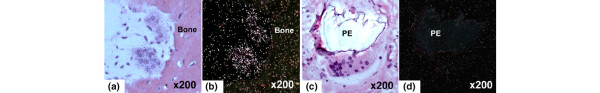
Detection of CTR mRNA in sections of human peri-implant tissues. The techniques used were in situ hybridization with a 35S-labeled antisense RNA probe ((a, c) bright field and (b, d) dark field). Expression of CTR mRNA is evident only in multinuclear cells in contact with the bone surface (panels a and b). Cells associated with polyethylene (PE) particles do not express detectable CTR mRNA (panels c and d).